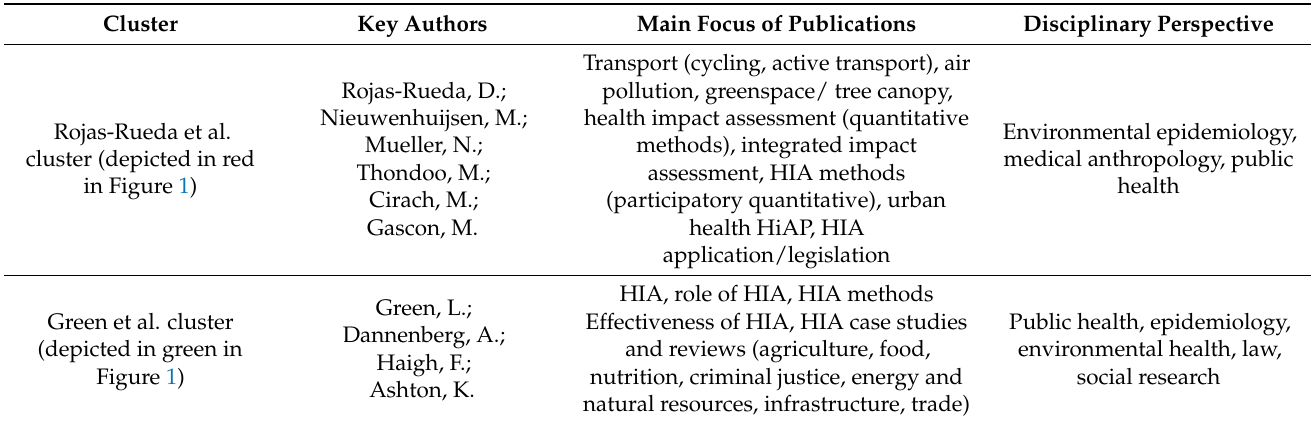
Figure 1. Co-authorship map of 229 publications on health in EIA and HIA. Each circle denotes an author. The size of the circles indicates the total link strength of the author. The larger the circle, the stronger the total strength of the co-authorship links of the author with other authors. In other words, we can assume that the authors with a larger circle are nodes in the clusters. The distance between circles represents the relative strength of the co-author relationships. The colours represent clusters of close co-authorship relationships. Table 1. Main co-authorship clusters of 229 publications on health in EIA and HIA.